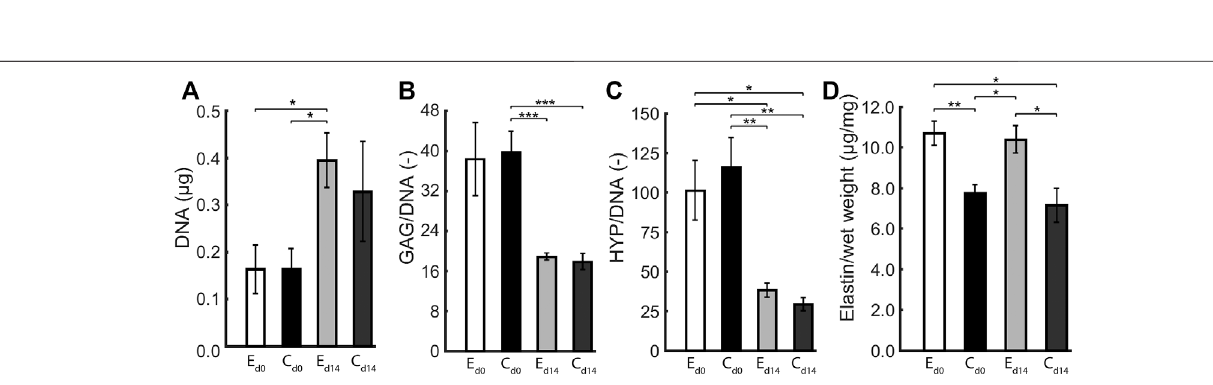
FIGURE 5 | Average (A) DNA content, (B) GAG per DNA, (C) HYP per DNA, and (D) (tropo)elastin per wet weight in elliptical (E) and circular (C) constructs before (d0) and after 14 days (d14) of dynamic loading. One asterisk (*) represents p ≤ 0.05, two p ≤ 0.01, and three p ≤